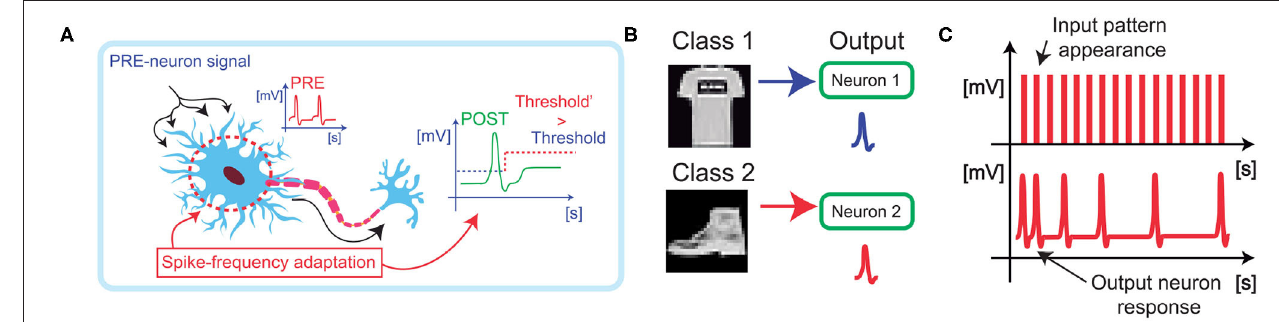
FIGURE 1 | (A) Biological neurons are stimulated by spikes coming from the synaptic connections and modulate their response in frequency as a function of the spiking activity. (B) By implementing the spike frequency adaptation in hardware, it is possible to introduce a boundary for the learning activity of large images, e.g., from the Fashion-MNIST dataset, thus boosting the overall specialization accuracy. (C) Furthermore, the specialization of the output neuron results in a decrease the firing activity of the neuron, thus optimizing the energy